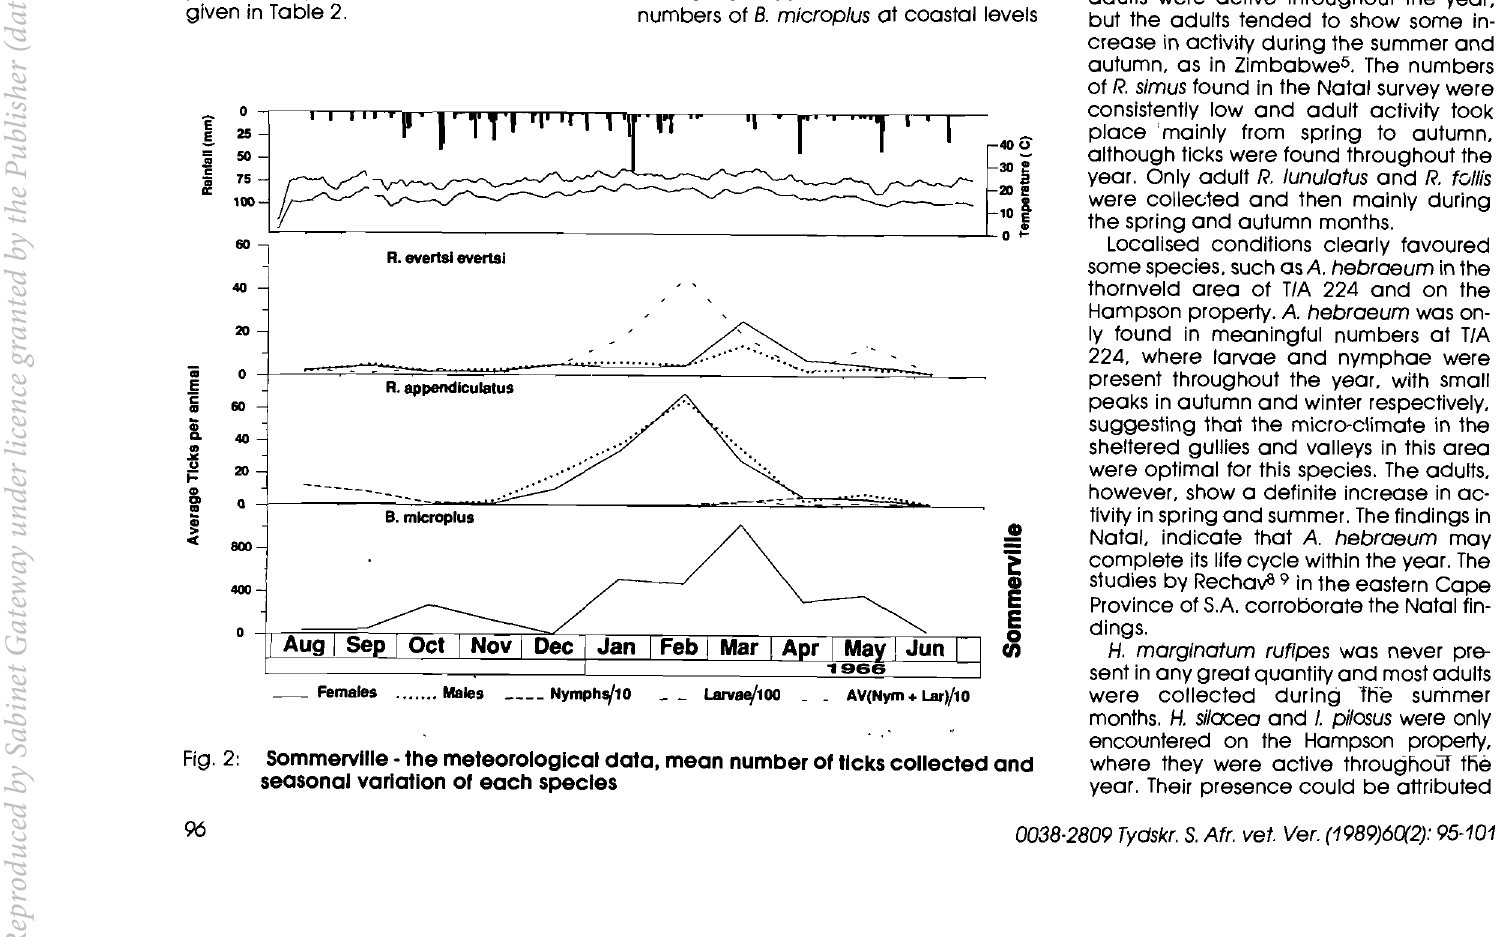
Fig. 2: Sommerville - the meteorological data, mean number of ticks collected and seasonal variation of each